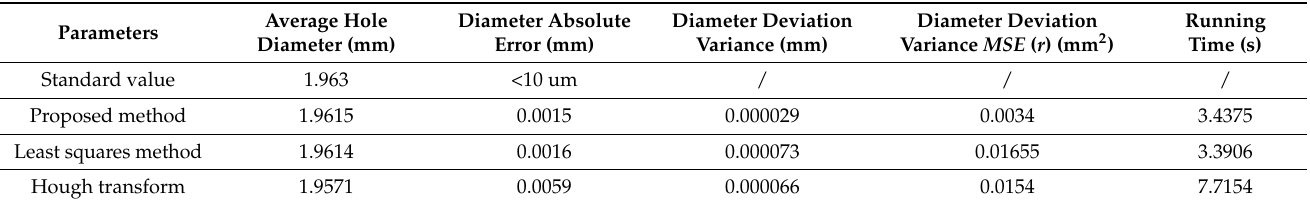
Table 3. The measurement parameters of 145 type of punched steel